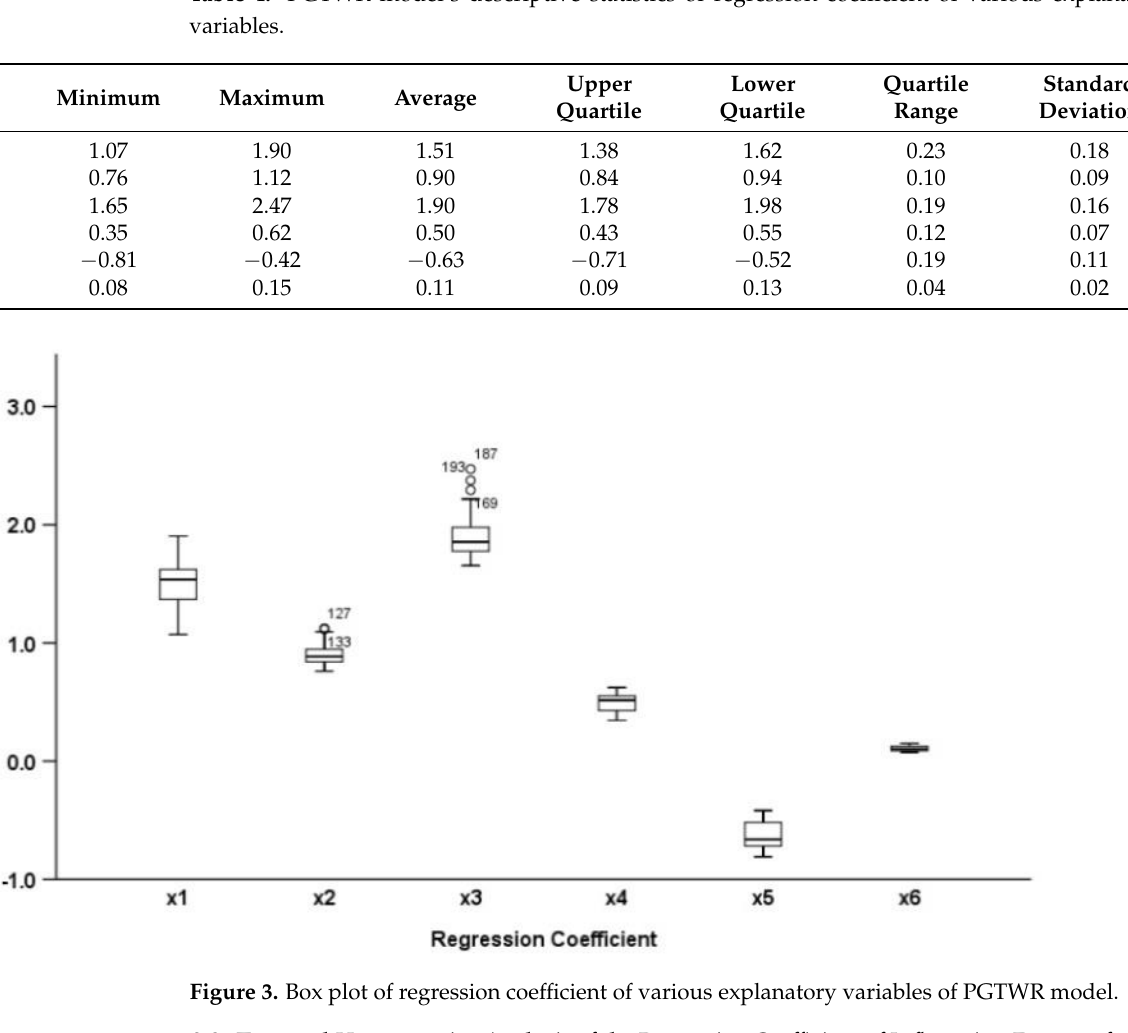
Table 4. PGTWR model’s descriptive statistics of regression coefficient of various explanatory var- iables.